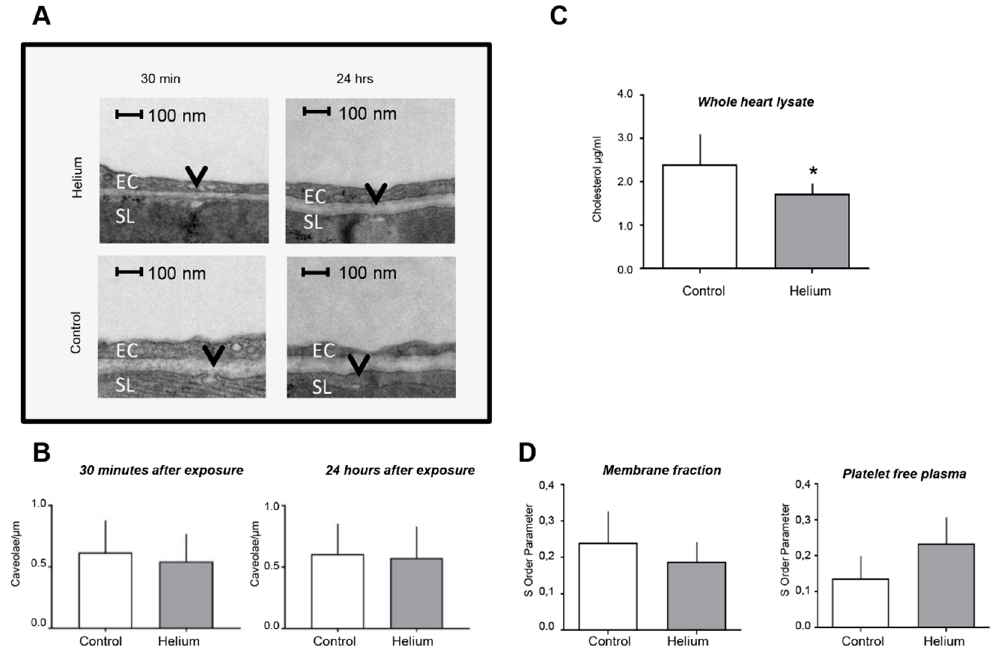
Figure 5. Assessment of cardiac ultrastructure and serum membrane fluidity post helium exposure. ( A ) Representative TEM images from left ventricular membranes of heart cells displayed per group, magnification 11,000 × . Caveolae are indicated by the black arrow. EC: endothelial cell, SL: sarcolemma. No ultrastructural di ff erences in cardiomyocytes were observed. ( B ) The number of caveolae in the sarcolemma of left ventricular myocytes are depicted as caveolae / µ m for both time points, no significant di ff erences were observed. All groups had the same sample size ( n = 4 animals / group, n = 22–33 images acquired per animal). ( C ) Histogram shows the results of the cholesterol assay of whole-heart tissue in µ M / mL. Twenty-four hours after helium exposure significantly less cholesterol was left in whole-heart tissue, n = 6 (control), n = 8 (helium). ( D ) The EPR histogram shows the changes in the S order parameter 24 h after He inhalation in membrane fractions and PFP, n = 4. The S order parameter is directly proportional to the membrane rigidity. No significant changes were observed. However, a trend towards decreased rigidity in the He group and increased rigidity in PFP can be appreciated when evaluating dedicated histograms. Data are shown as mean ± SD.